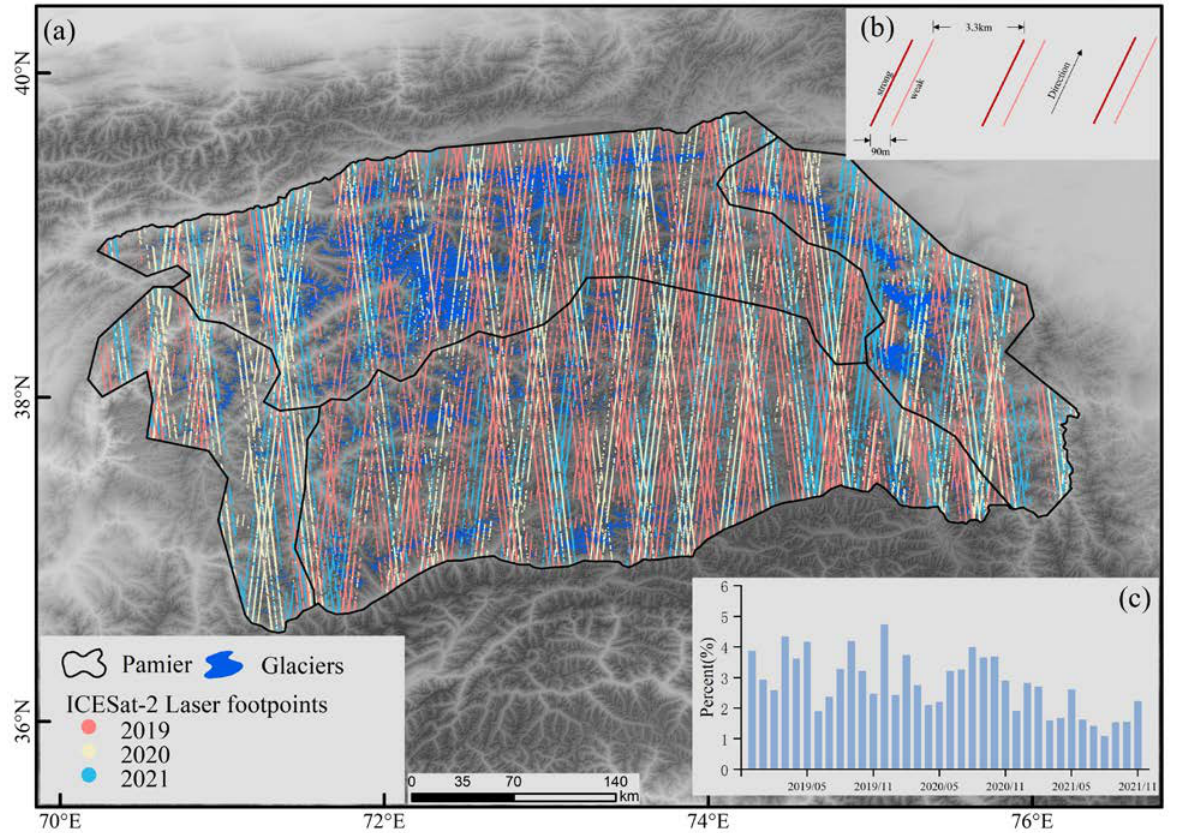
Figure 2. ICESat-2 footprint distribution. ( a ) Distribution of ICESat-2 footprints in the Pamir. ( b ) Relative location of six beams for backward orientation of advanced topographic laser altimeter system (ATLAS). ( c ) Percent of ICESat-2 data acquired in different months from October 2018 to November 2021.